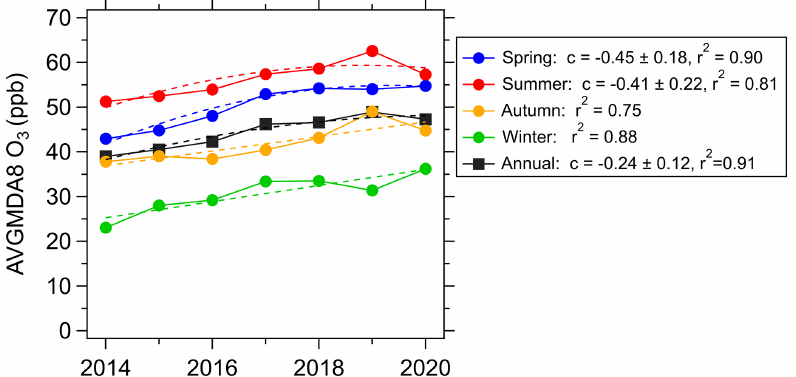
Figure 5. Variations in seasonal and annual AVGMDA8 O 3 levels during 2014–2020. The trends for spring, summer and annual averages are fitted by the polynomial function ( y = a + bx + cx 2 ) and the trends for autumn and winter are fitted by the linear function ( y = a + bx). The quadratic polynomial coefficient c ( ± 1SD) and the determination coefficient r 2 are